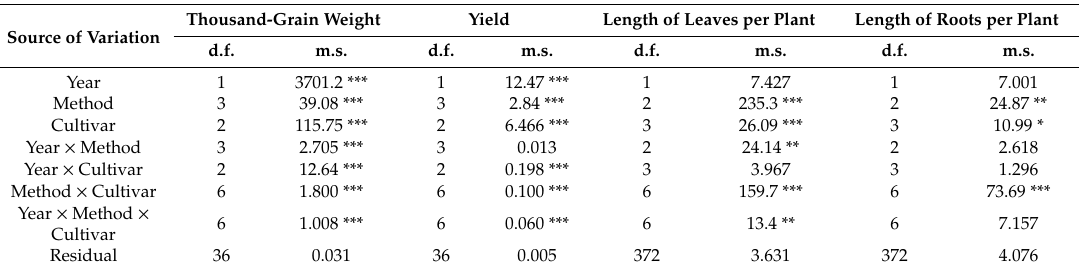
Table 2. Mean squares (m.s.) from three-way analysis of variances for four observed